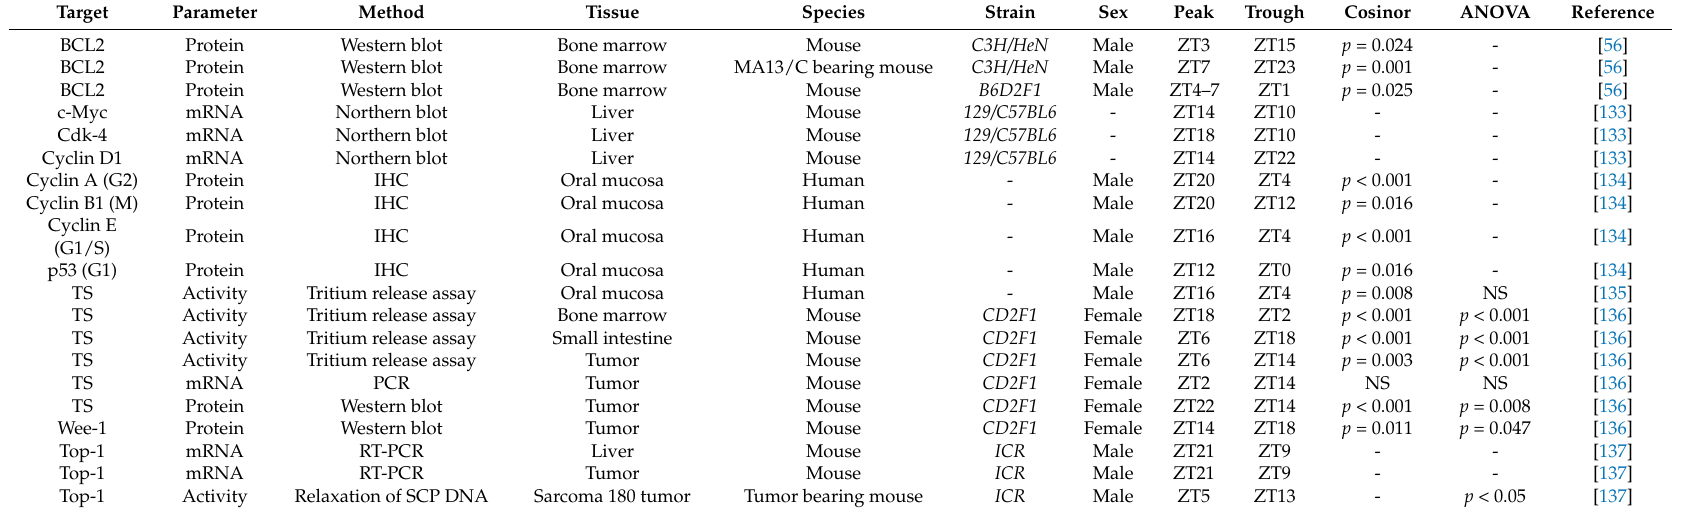
Table 3. The targets of the anticancer drugs that are under the control of circadian